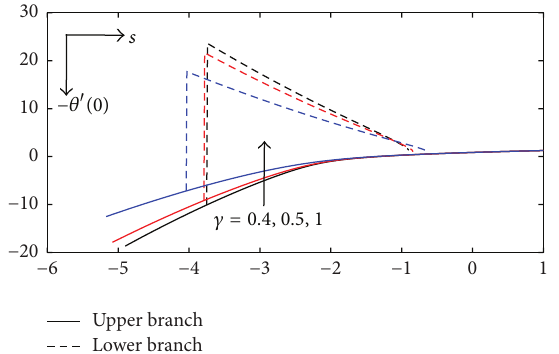
Figure 8: Temperature profiles for various values of 𝑀 with 𝑠 = −3 , 𝛾 = 0.5 , 𝜆 = 1 , and Pr = 3